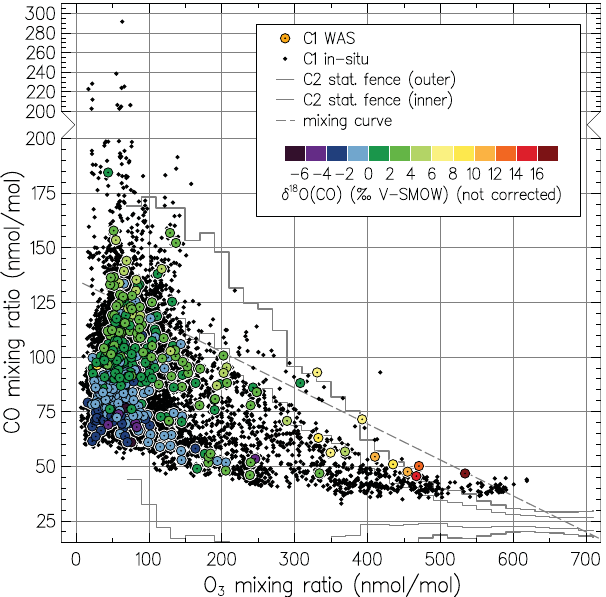
Figure 2. (accompanies Fig. 1) Carbon monoxide and ozone mix- ing ratios measured in C1. Small black symbols denote the C1 in situ measurements ( n =12753). The C1 WAS analyses ( n = 408) are shown with large symbols; colour denotes the concomitant δ 18 O(CO) measurements. Thin and thick step lines denote the inner and outer statistical fences of the C2 data, respectively. The dashed curve exemplifies compositions expected from the linear mixing of tropospheric and stratospheric end members (see caption to Fig. 1 for